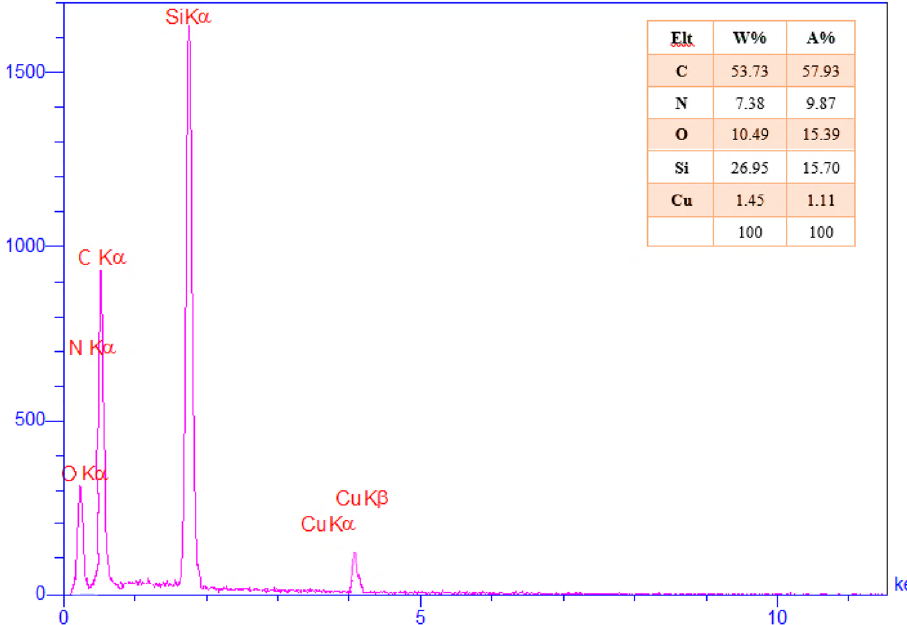
Figure 6. EDX analysis of the Cu@APS-TDU-PMO nanocomposite ( 1 ).